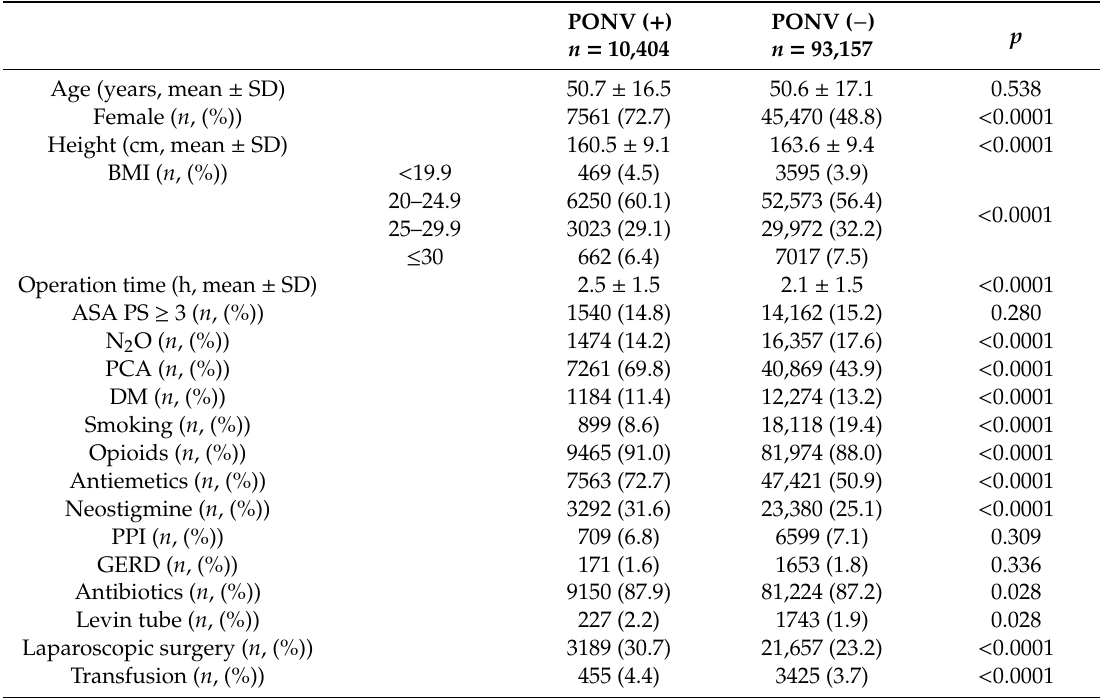
Table 1. Baseline characteristics of the